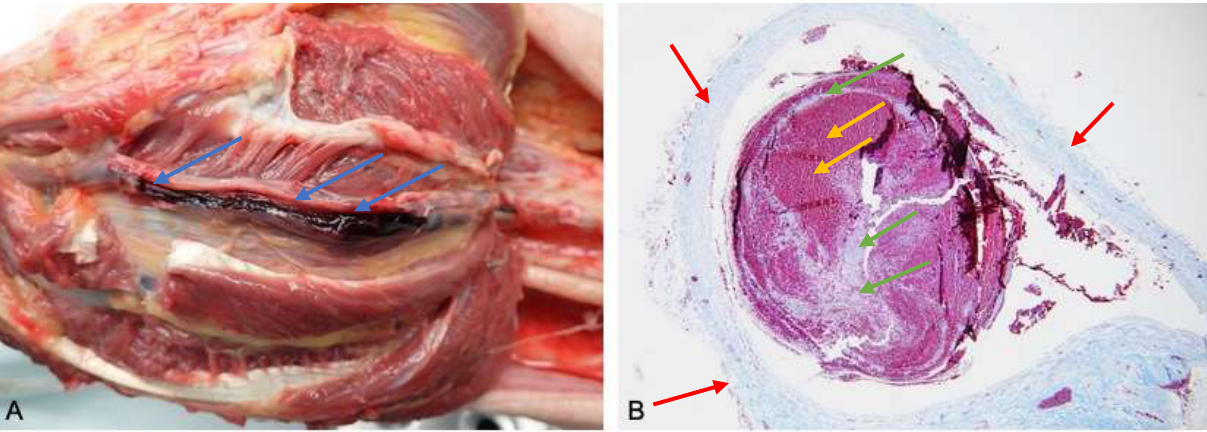
Figure 3. ( A ) Macroscopic autopsy findings. Thrombi are noted in the lumen of the posterior tibial vein (blue arrow). ( B ) Histological examination (Masson’s trichrome 60 X), the antemortem thrombosis within the vein lumen (vein wall red arrow), which contain the so-called “lines of Zahn” (green arrow), representing the layerwise, alternating deposition of erythrocytes (yellow arrow), leukocytes and fibrin within the vessel lumen.